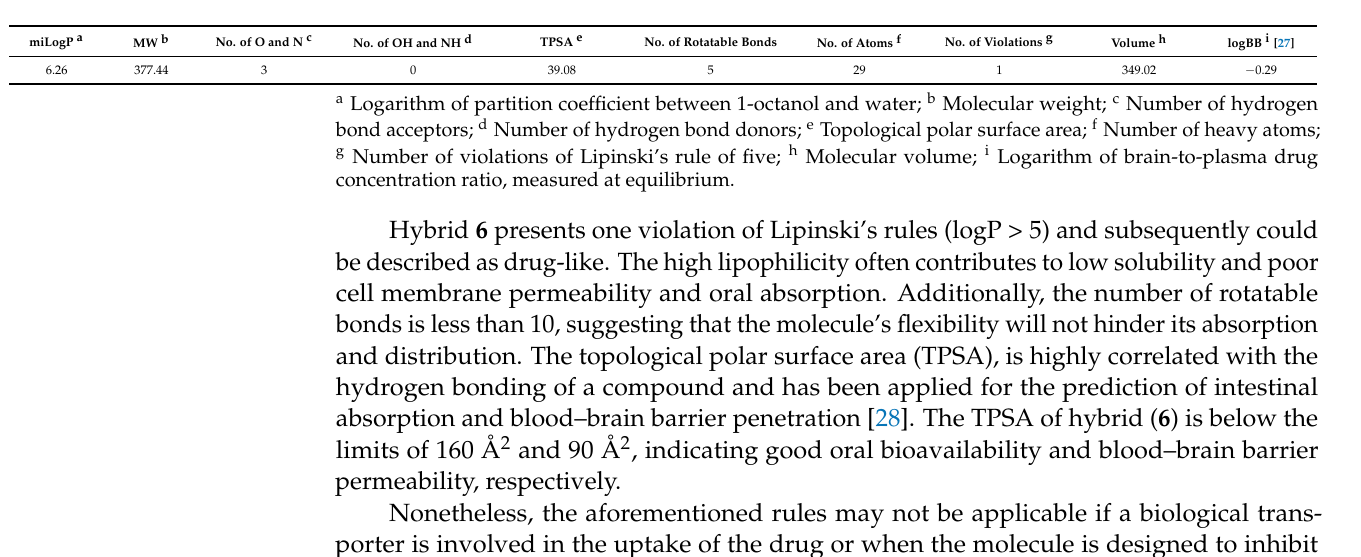
Table 1. Drug-likeness of the synthesized hybrid 6 . Molecular properties prediction—Lipinski “rule of